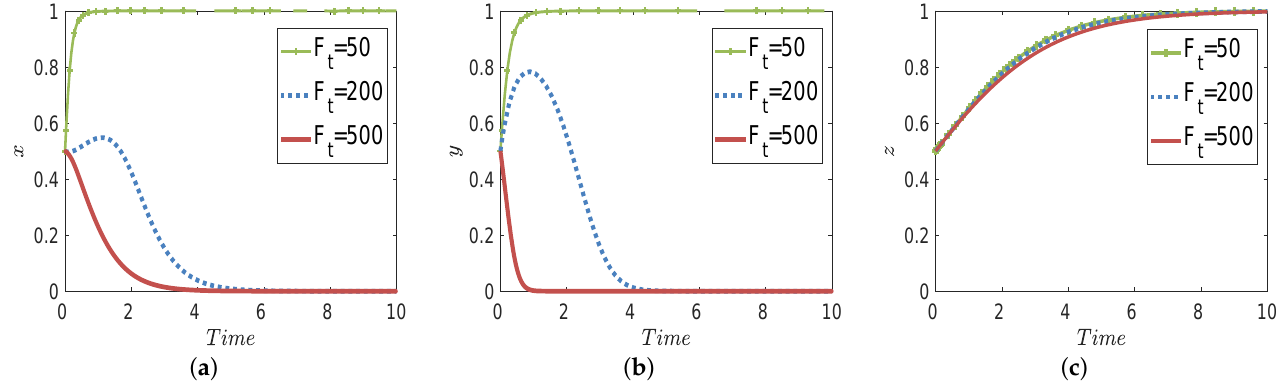
Figure 7. The impact of F t on evolution: ( a ) crowd workers; ( b ) crowdsourcing platforms; ( c ) task